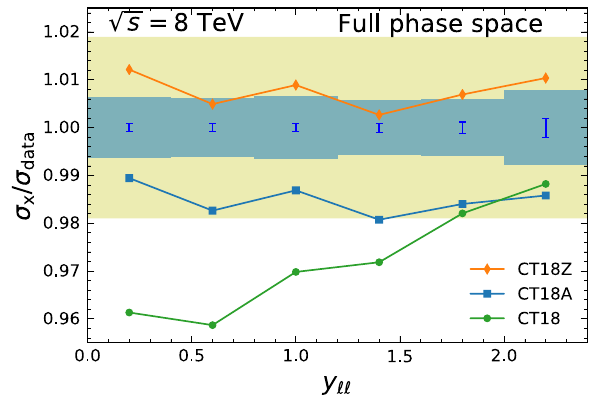
Fig. 10 Ratio of the predicted to the measured d σ/ d y (cid:4)(cid:4) cross section. The ratios are calculated in the full phase space using the CT18, CT18A and CT18Z NNLO PDF sets, as indicated in the legend. The error bands and error bars centered at one show the data normalisation, total exper- imental (excluding normalisation) and statistical